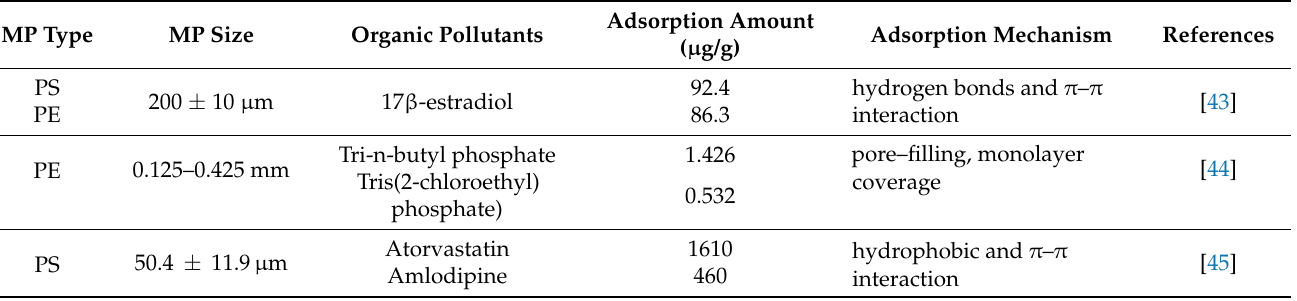
Table 3. Comparison of the adsorption capability and adsorption mechanism towards organic pol- lutants of the studied MPs.